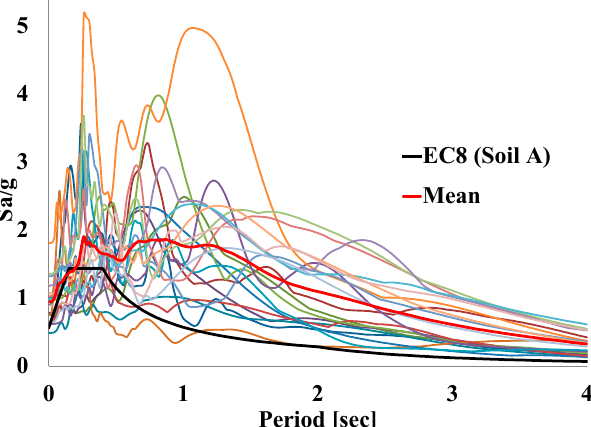
Figure 5. Acceleration elastic response spectra for 5% damping of the near-fault excitations (Reprinted from Computers and Structures, Volume 243, Alexandros Tsipianitis and Yiannis Tsompanakis, Optimizing the seismic response of base-isolated liquid storage tanks using swarm intelligence algorithms, Pages No. 106407, Copyright (2022), with permission from